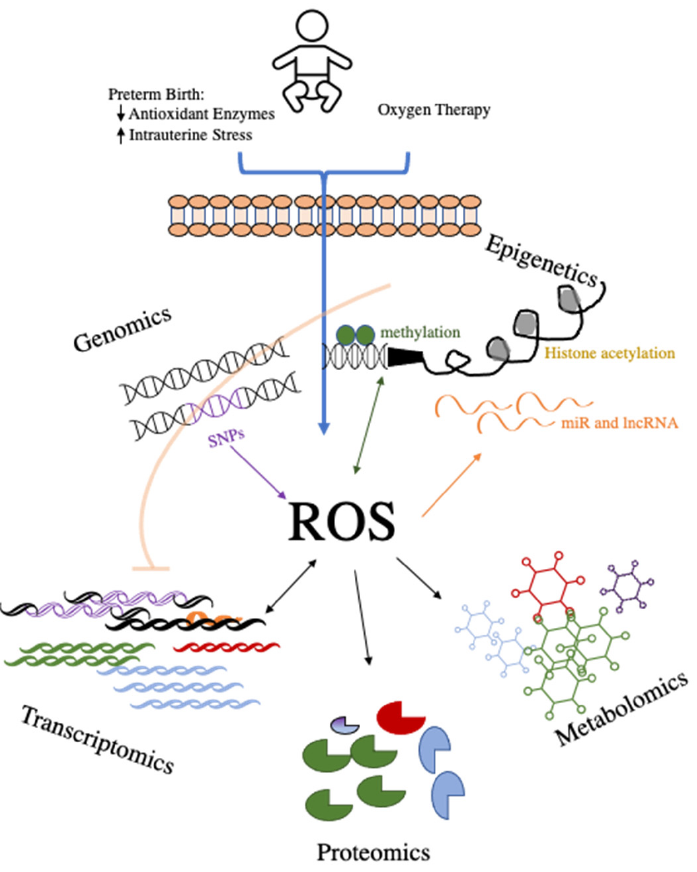
Figure 1. Schematic overview of the interactions of the ‘omics’ and reactive oxygen species (ROS) in preterm infants.